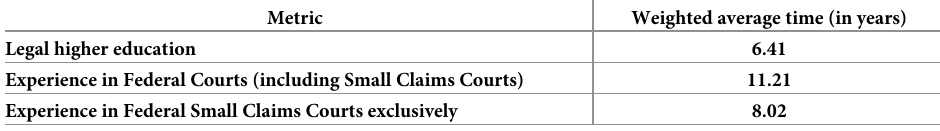
Table 6. Experience and education data about the experts that labelled our